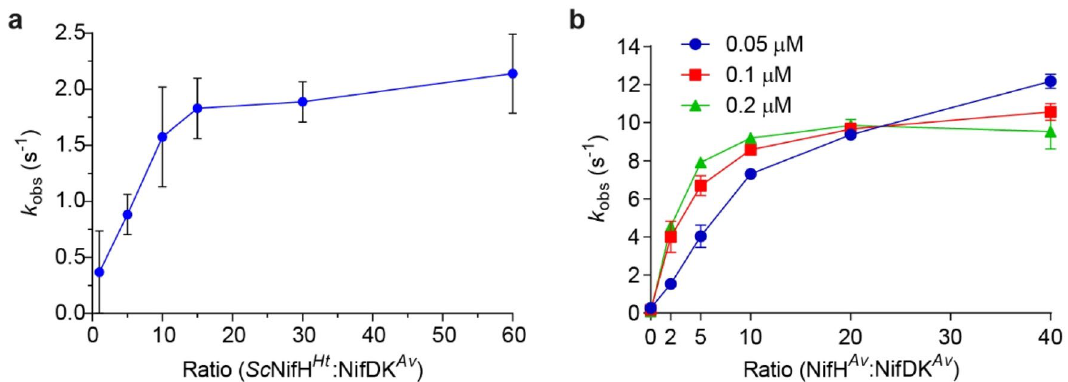
Figure 2. Adaptation and optimization of S 2 V red for nitrogenase activity determination using 96-well microtiter plates. (a) Nitrogenase activity ( k obs (s −1 )) measured in a cuvette using Sc NifH Ht and NifDK Av at 0–60 × molar ratios in reactions containing 0.4 µM NifDK Av . Mean and SD is shown. n = 2 technical replicates. (b) Nitrogenase activity ( k obs (s −1 )) measured in a 96-well microtiter plate using NifH Av and NifDK Av at 0–40 × molar ratios in reactions containing 0.05 µM (blue dots), 0.1 µM (red squares) or 0.2 µM (green triangles) NifDK Av . Mean and SD is shown. n = 2 technical